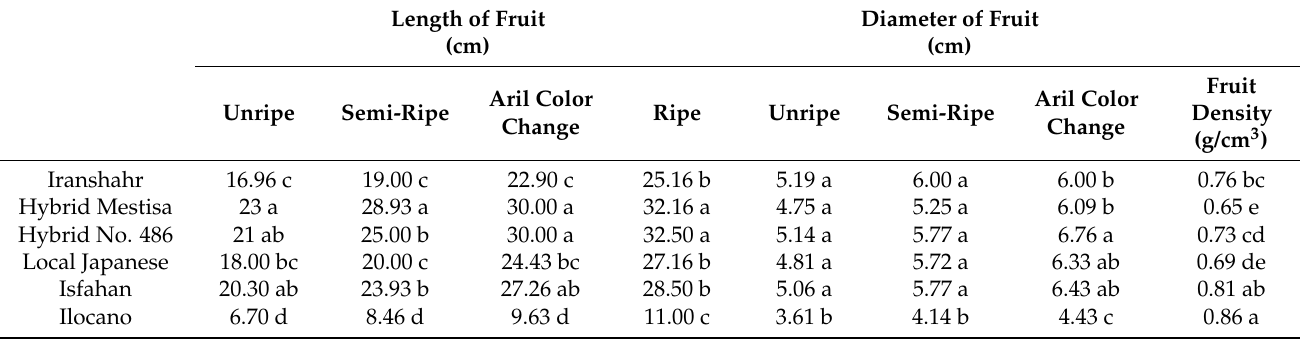
Table 3. Mean comparison of the fruit characteristics of six bitter melon cultivars at different developmental stages. Length of Fruit Diameter of Fruit (cm) (cm) Aril Color Unripe Semi-Ripe Ripe